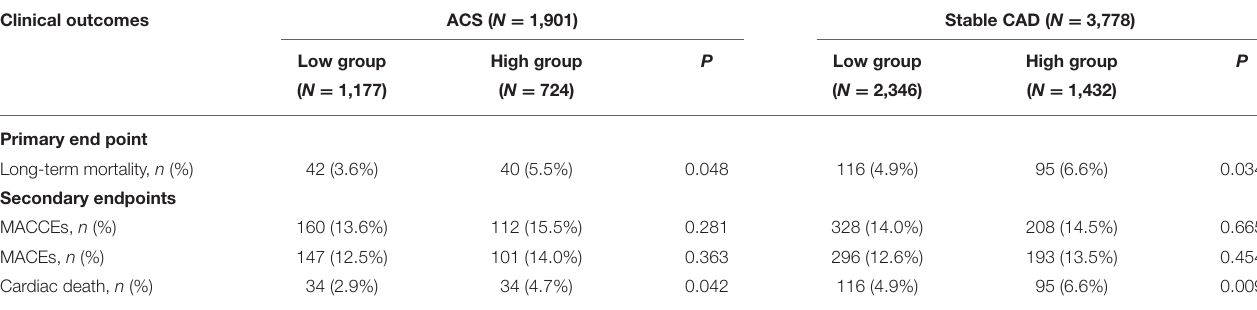
TABLE 2 | Clinical outcomes comparison between groups. Clinical outcomes